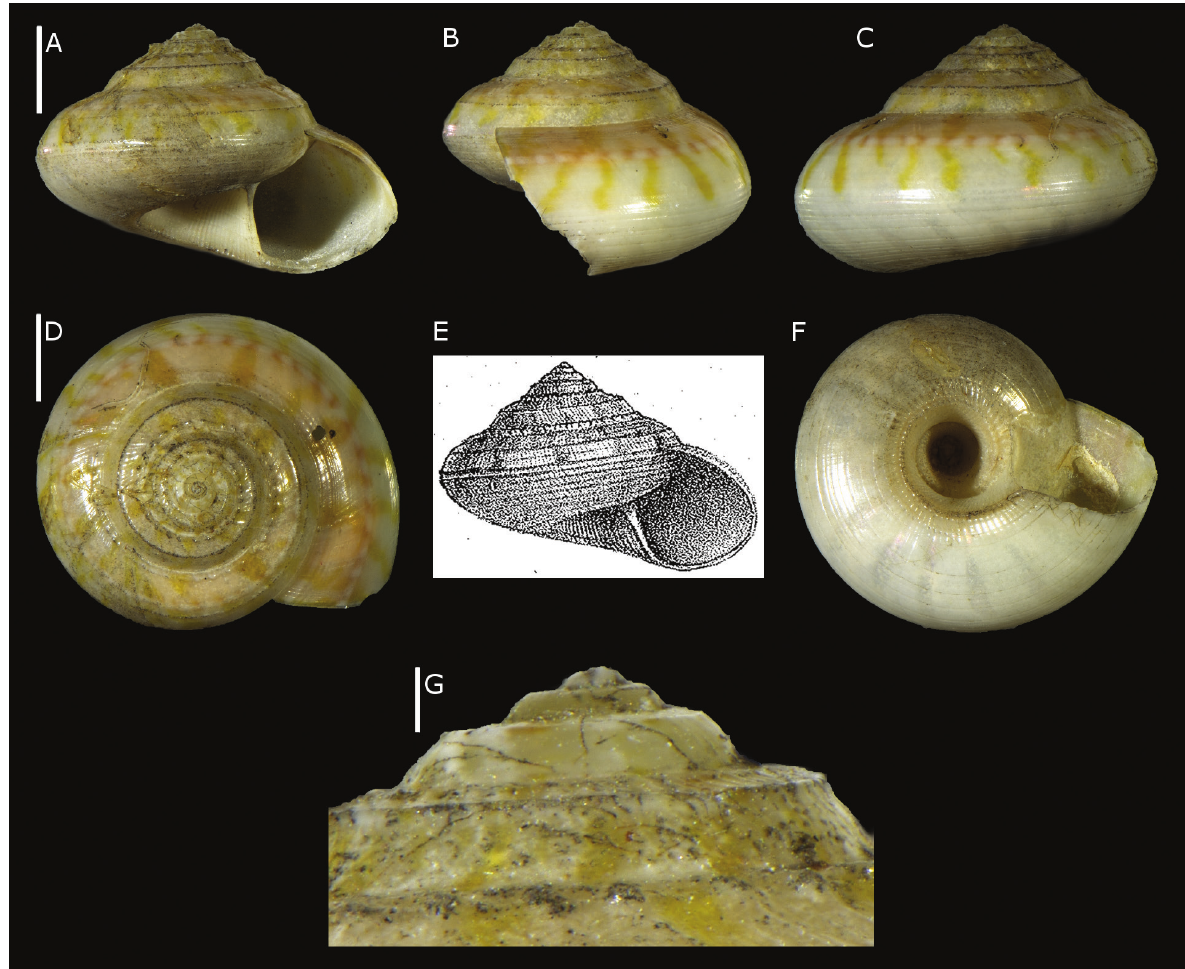
Figure 3. Solariella illustris Sturany, 1900, Station 48 (Yanbu’ al Bahr, Saudi Arabia, Red Sea). A–D, F–G . Figured syntype, NHMW 84287: front ( A ), right side ( B ), back ( C ), top ( D ), bottom ( F ), apex ( G ). E . Original figure by Sturany (1903). Scale bars: A–D, F : 2 mm, G : 0.2